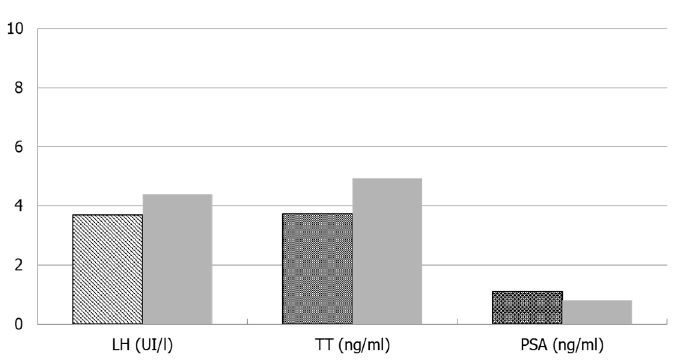
Figure 1. Luteinizing-hormone (LH), total testosterone (TT), and prostatic-specific antigen (PSA) before and after VLCKD.